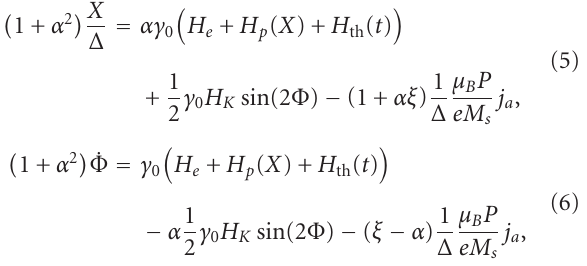
(cid:2) r (cid:4) ) of the finite di ff erence mesh,